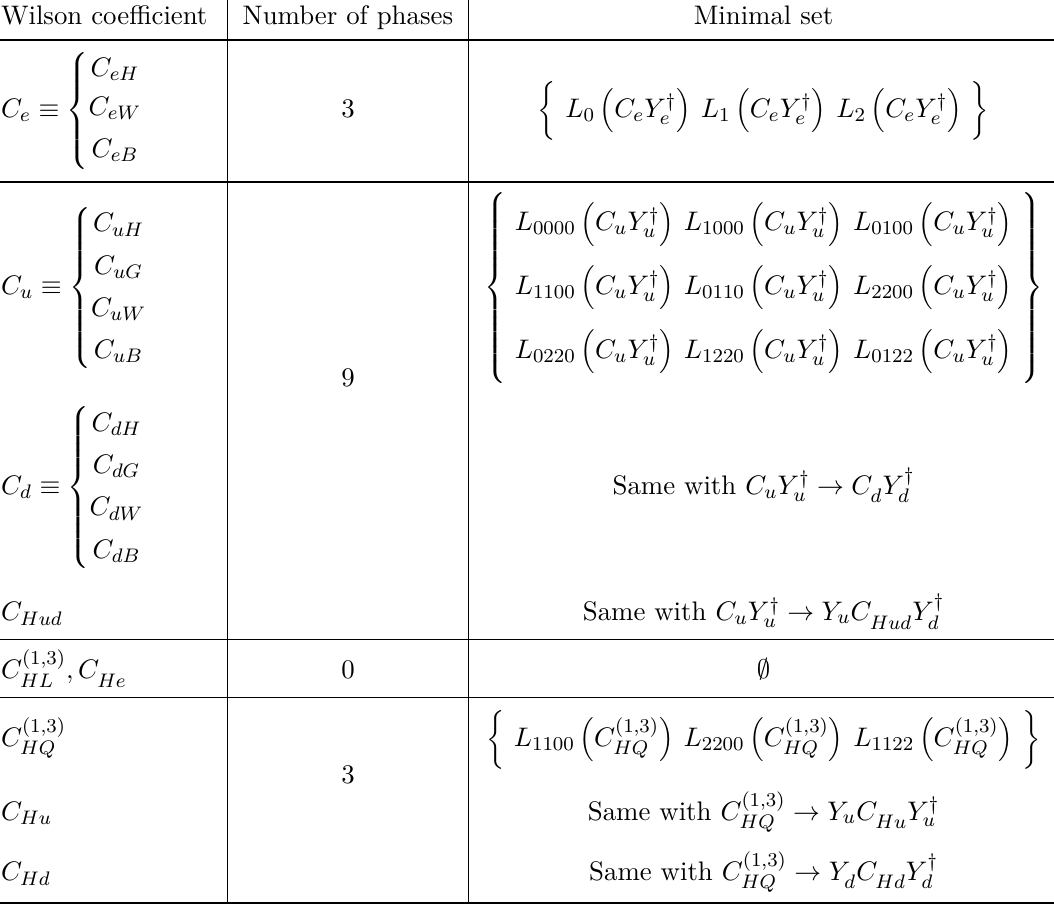
, and similarly for u